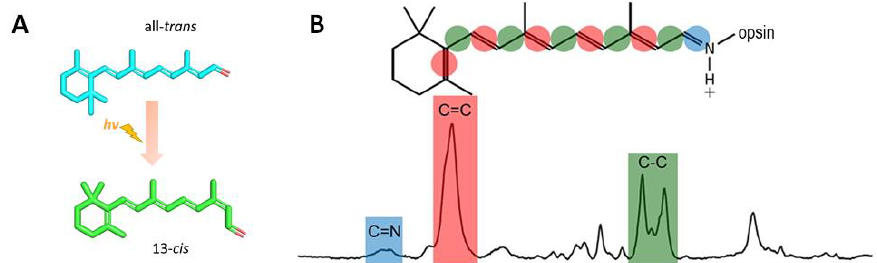
Figure 11. Resonance Raman spectroscopy (RRS) applied to determine chromophore structure in rhodopsins. ( A ) Retinal chromophore photoisomerization in microbial rhodopsins. It should be noted that animal (Type-2) rhodopsins typically utilize 11-cis/all-trans retinal configurations in the ground state. ( B ) Typical RRS spectra of a microbial rhodopsin. Adapted from [301] with permission from ACS Publications.